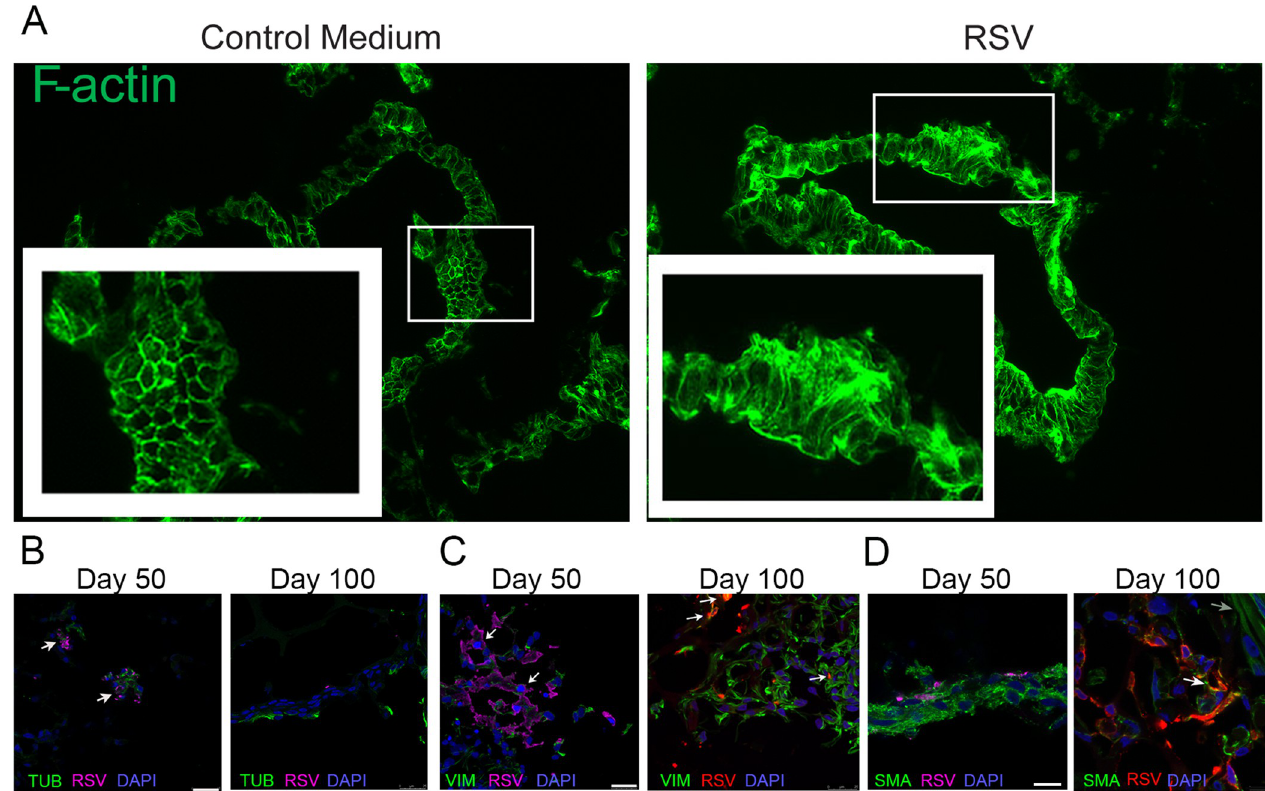
Fig 4. RSV-induced Remodeling of cytoskeletal proteins. (A) At 5 days after RSV infection, immunohistochemical staining for F-actin shows extensive remodeling and rearrangement of the HLO’s cytoskeletal architecture. This pattern is consistent with the role played by actin and profilin in virus-mediated cell fusion and viral maturation. HLOs at 50 and 100 days in culture, infected with 8X10 3 pfu rrRSV for 72 hours, and immunohistochemical staining for (B) Tubulin and RSV (C) vimentin and RSV and (D) smooth muscle actin and RSV shows viral infection is greater in 50 days HLOs. Scale bars 25 μ m.